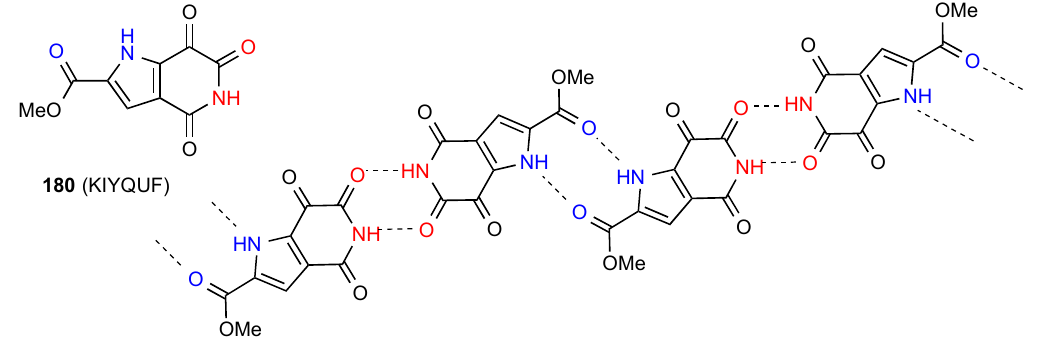
Figure 56. Structure adopted by compound 180.